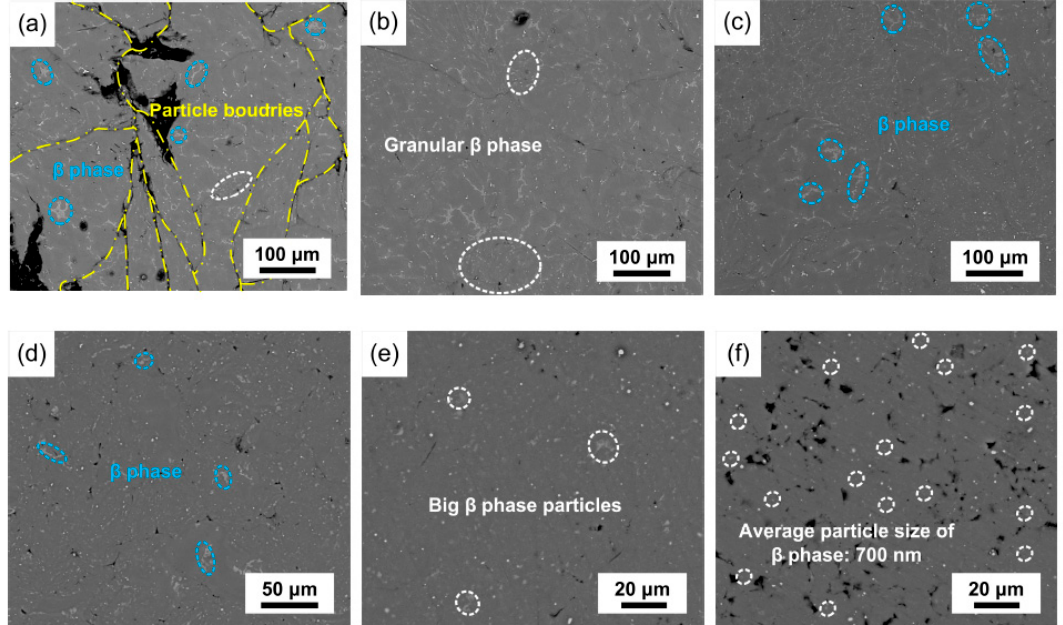
Figure 4. Microstructural evolution of AZ91: ( a ) 15 min; ( b ) 30 min; ( c ) 60 min; ( d ) 120 min; ( e ) 180 min; ( f ) 240 min.